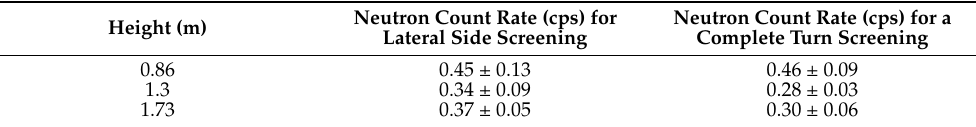
Table 6. Neutron count rate and standard deviation obtained with the EJ-426HD detection sys- tem integrated in the drone considering Troxler equipment placed at the bottom corner of the shipping